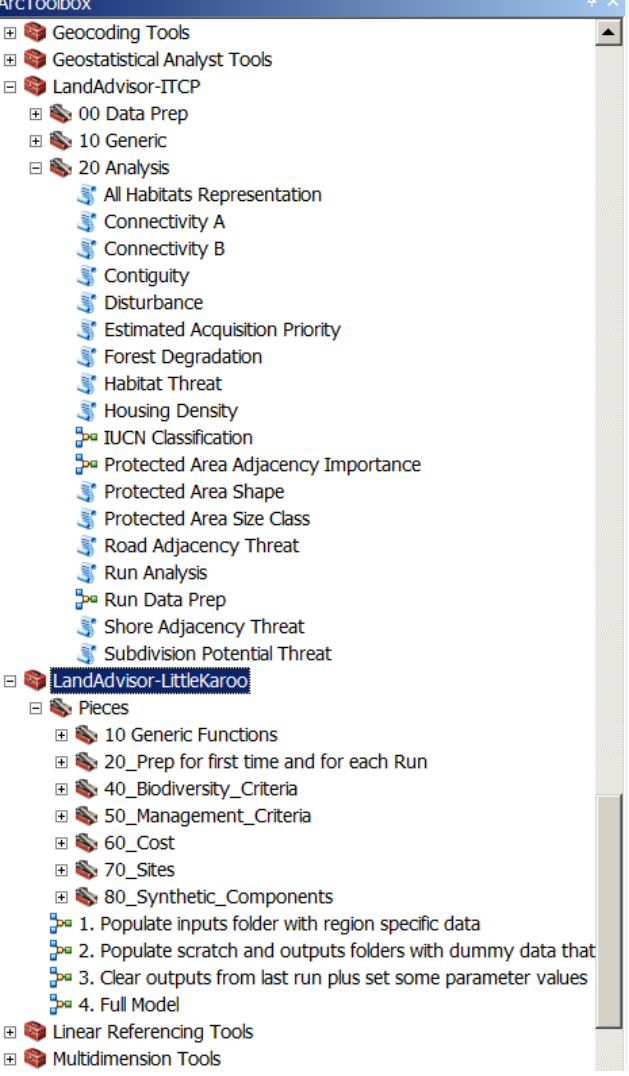
Figure 10. Two past Earthwise toolboxes in ArcGIS. Earthwise was originally called LandAdvisor. Here, the Earthwise-LK (LandAdvisor-LittleKaroo) Toolbox is comprised of sub-toolboxes and models as well as synthetic models that pull together all of the pieces. Clicking on a + expands the toolbox to display sub-toolboxes and models. Models can then be run, or viewed to see every methodological detail. Earthwise-ITCP (LandAdvisor-ITCP) of the Islands Trust of British Columbia, is a python-based version with more vector based processing, and also released open access, with sample